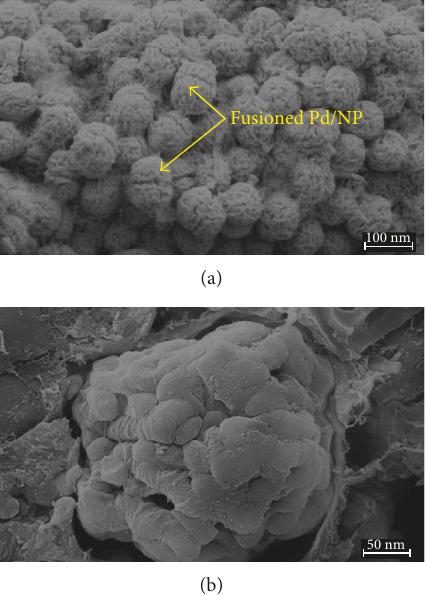
Figure 4: (a) FE-SEM of Pd/NPs deposit on the surface of the ceramic catalyst; (b) detail on a single Pd/NP.